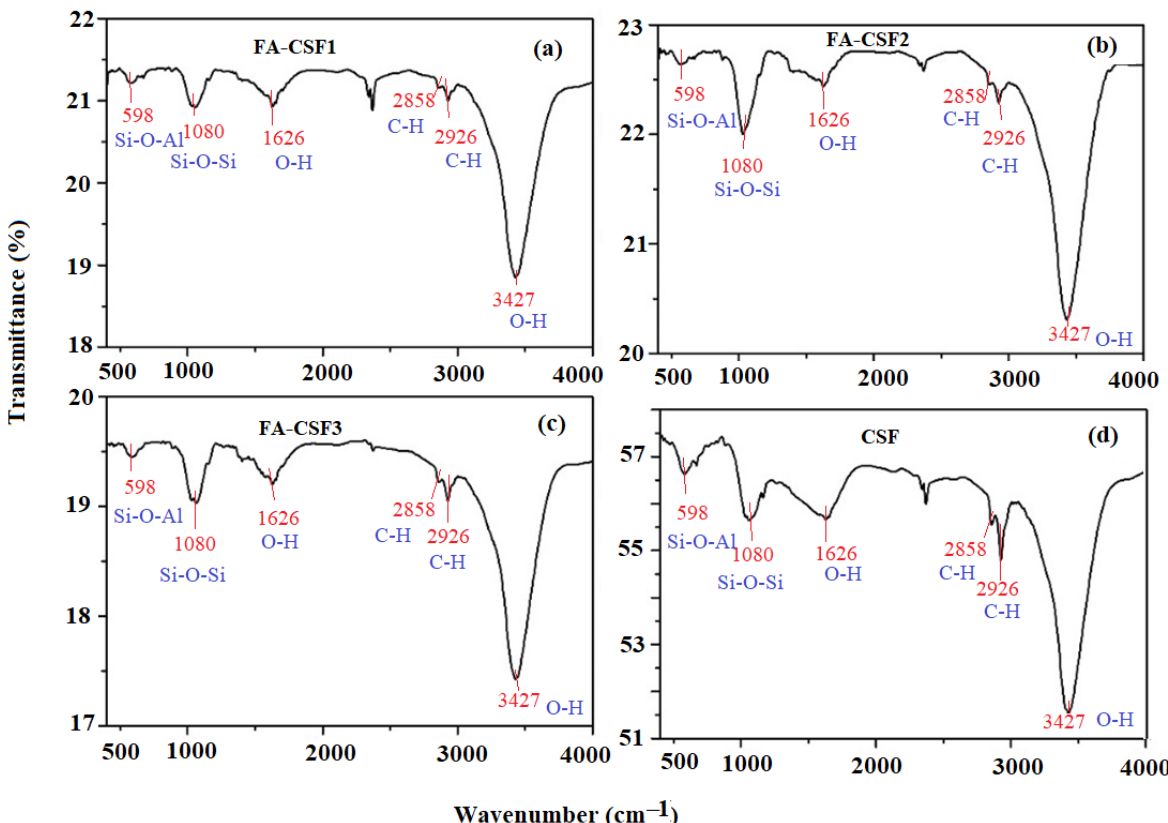
Figure 1. Fourier transform infrared spectra for chitosan-based film (CSF) and fly ash loaded chitosan-based film (FA-CSF), where ( a ) FA-CSF1, ( b ) FA-CSF2, ( c ) FA-CSF3, and ( d ) CSF.